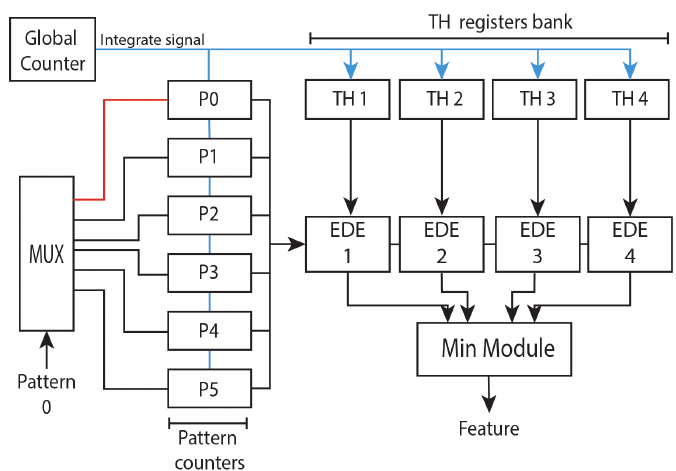
Figure 6. Histograms comparator module (HGCM). The blue signal is asserted when the global counter reaches the integration time, given by the τ value. At that moment, the content of the Pattern counter, which is the histogram of the activated features, is compared with the trained histograms (TH).